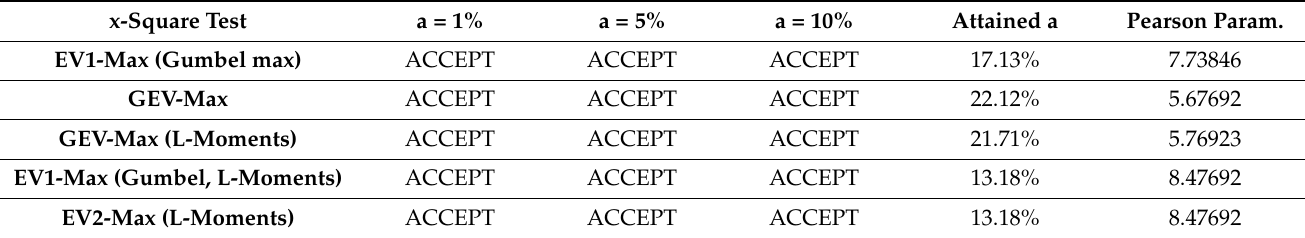
Figure 3. The 24-h maximum annual rainfalls depicted in a normal scatter plot with the tested distributions. Table 3. Distributions’ performance subjected to χ 2